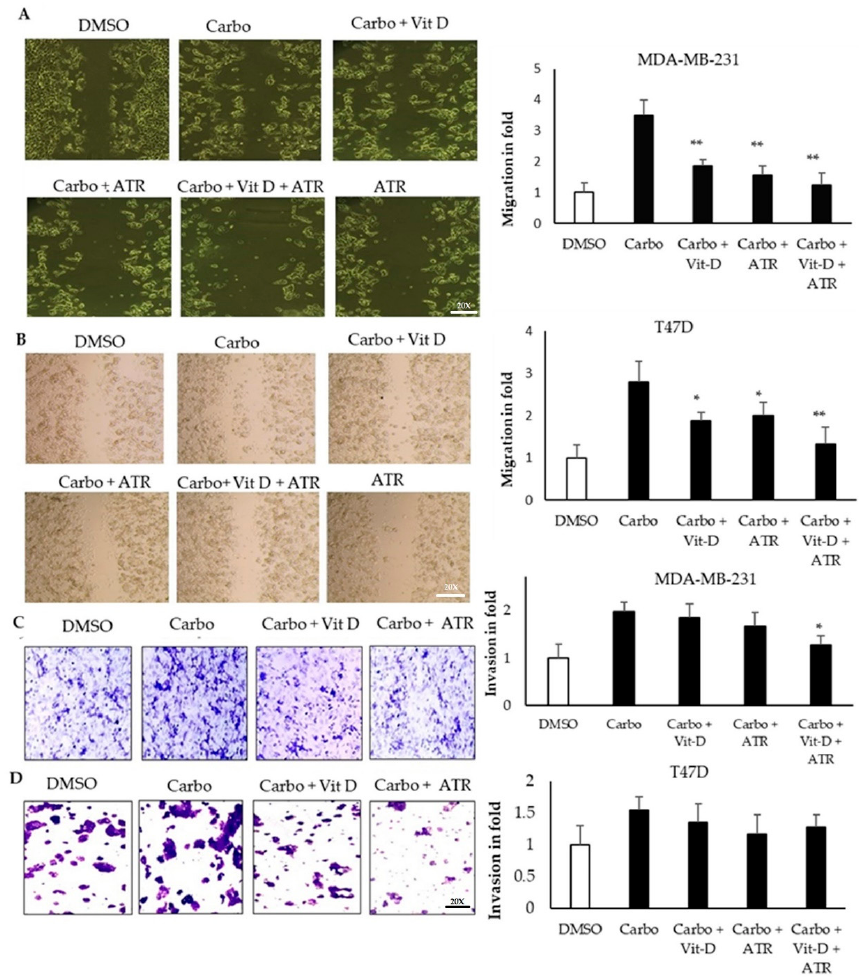
Figure 6. Atropine abrogates the carboplatin (cardo)-induced vit-D-supplemented cancer stem cell modifications in breast cancer cell lines. MDA-MB-231 and T47D cell monolayers were treated with carboplatin only, carboplatin (5 nM)-treated vit-D- β (10 nm), carboplatin and atropine (25 µmol/L) treatments, or carboplatin, vit D, and atropine. The migration activity ( A , B ) was assessed using EVOS optical microscope (200× magnification). ( A ) The phase-contrast microscopic images of treated MDA-MB-231 cell lines were recorded, right side. ( B ) Same recording for T47D for recording wound-healing activity. ImageJ tool was used to calculate the area of recovered wounds. ( C,D ) Invasion activity of MDA-MB-231 and T47D cells treated with control, carbo, carbo and vit D, carbo and atropine, or carbo and vit D, and atropine. Data are shown as mean ± SD from a representative experiment out of three independent experiments studied in quadruplicates and produced similar results. * p < 0.05 and ** p < 0.01 (one-way ANOVA); horizontal bars denote statistical comparisons. Next, we checked the colony formation in both BC cell lines after being treated with carboplatin only or with carboplatin in combination with vit D or atropine. As shown in the representative images in Figure 7A, the cells were treated with atropine and vit D to